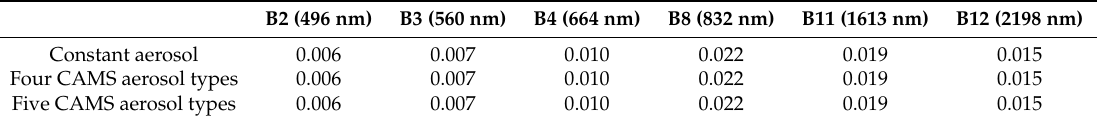
Table 11. Noise criterion of the MACCS-ATCOR Joint Algorithm (MAJA) surface reflectance time series, for vegetated sites. CAMS: Copernicus Atmosphere Monitoring